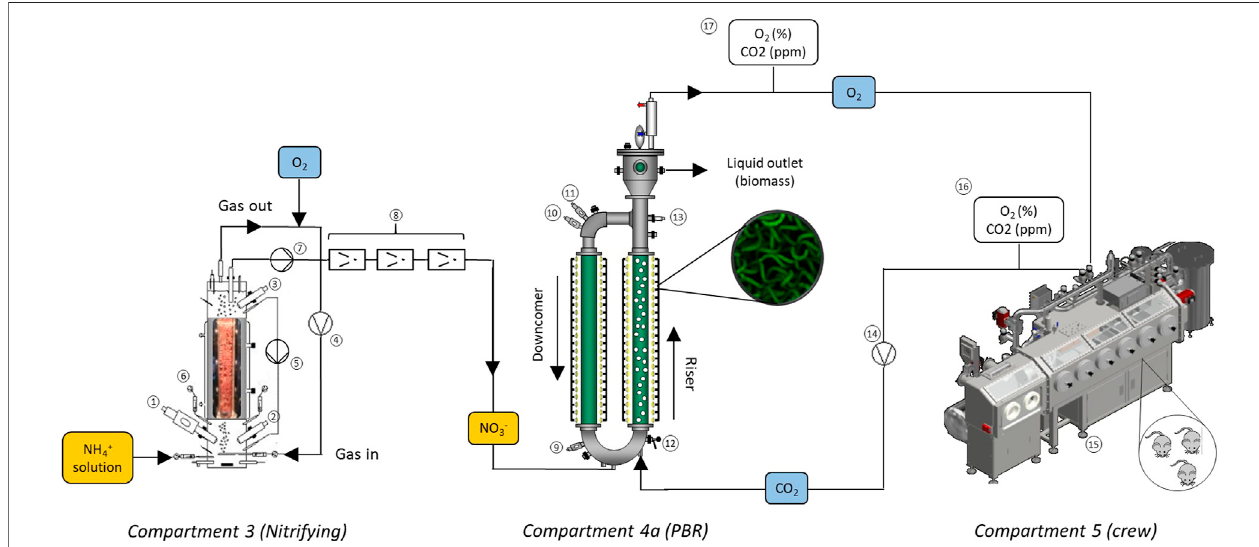
FIGURE 3 | Diagram for liquid connection between intriguing and photosynthetic compartments (C3-C4a), and gas connection between compartment 5 (animal isolator) and compartment 4a. The gas phase from the PBR (rich in O2) is send to the isolator. Then, the gas rich in CO2 is pumped back to the PBR. Compartment elements:see Panel 2 forelementsfrom1to13, 14-gas connection linebetweenC4a and C5, 15-animal isolator, 16-gas analyserinC5, 17-gas analyser inC4a outlet.